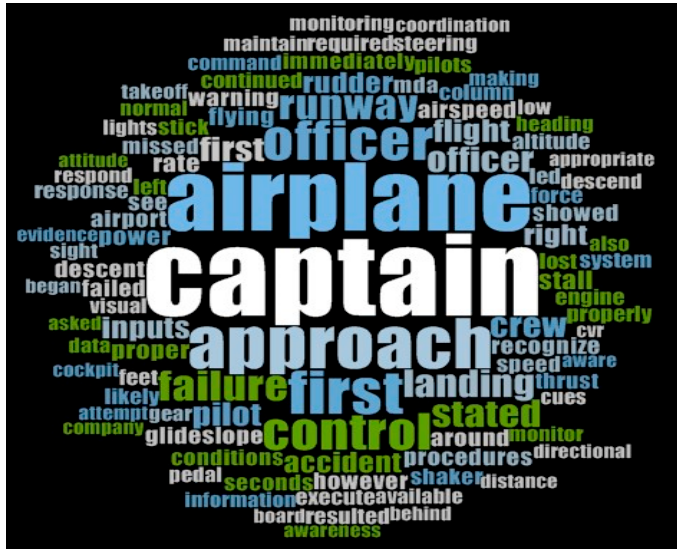
Figure 8. Word frequency tag cloud for Loss of Situational Awareness.